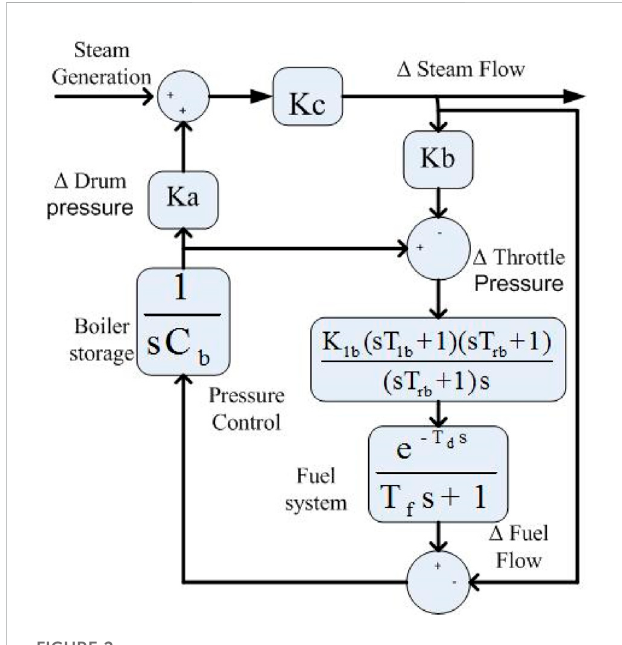
FIGURE 2 Transfer model of boiler